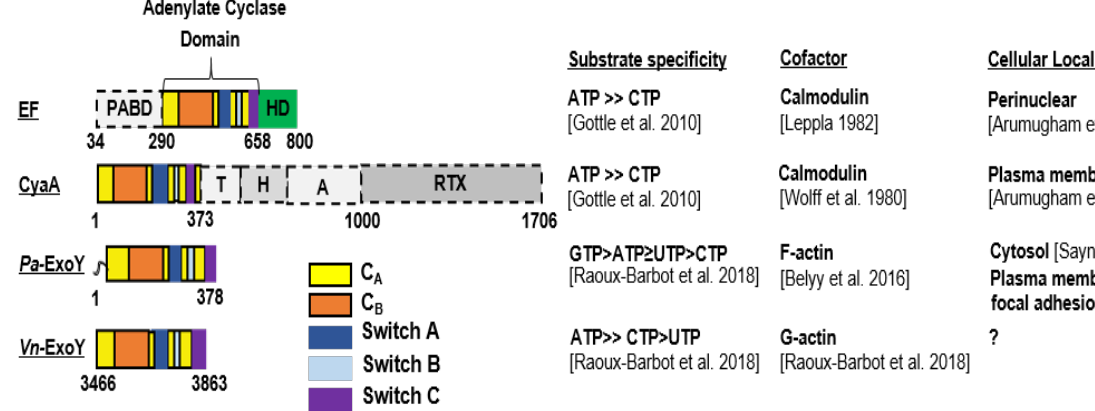
Figure 2. Domain organization, substrate specificity, activation cofactor and cellular localization of CaM-activated toxins CyaA and EF and actin-activated toxins, Pa -ExoY and Vn -ExoY. PABD, protective antigen binding domain; HD, helical domain; T, translocation region; H, hydrophobic region; A, acylation region; RTX, repeat-in-toxin [37–39]. (Note: ATP ≥ CTP [34]; GTP > ATP ≥ UTP > CTP and ATP ≥ CTP > UTP [21]; Calmodulin [8,9]; F-actin [17]; G-actin [21]; Perinuclear [40,41];